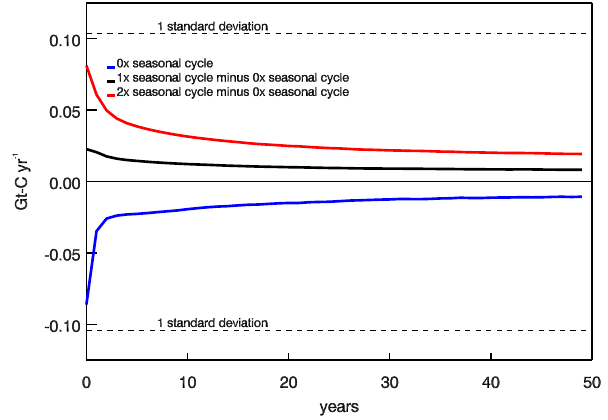
Fig. 10. Globally averaged air sea flux of CO 2 calculated as a dif- ference between an ocean-model simulation seeing constant atmo- spheric CO 2 for 286ppmv at all points, and spatially varying, but temporally constant (zero seasonal cycle) CO atm (blue). Globally 2 averaged air-sea flux of CO 2 calculated as a difference between the annual cycle of pre-industrial CO atm generated by the Earth 2 System Model control run (and adjusted so that the annual global mean is exactly 286ppmv) (black). Globally averaged air-sea flux of CO 2 calculated as a difference between two times the annual cy- generated by the Earth Sys- cle magnitude of pre-industrial CO atm 2 tem Model control run (and adjusted so that the annual global mean is exactly 286ppmv, and the annual mean at each point equals the annual mean of that grid-point in the Earth System Model control run) (red). The dashed lines represent one standard deviation of the globally annually averaged air-sea CO 2 flux calculated over 270yr of the fixed CO atm pre-industrial Earth System Model control 2